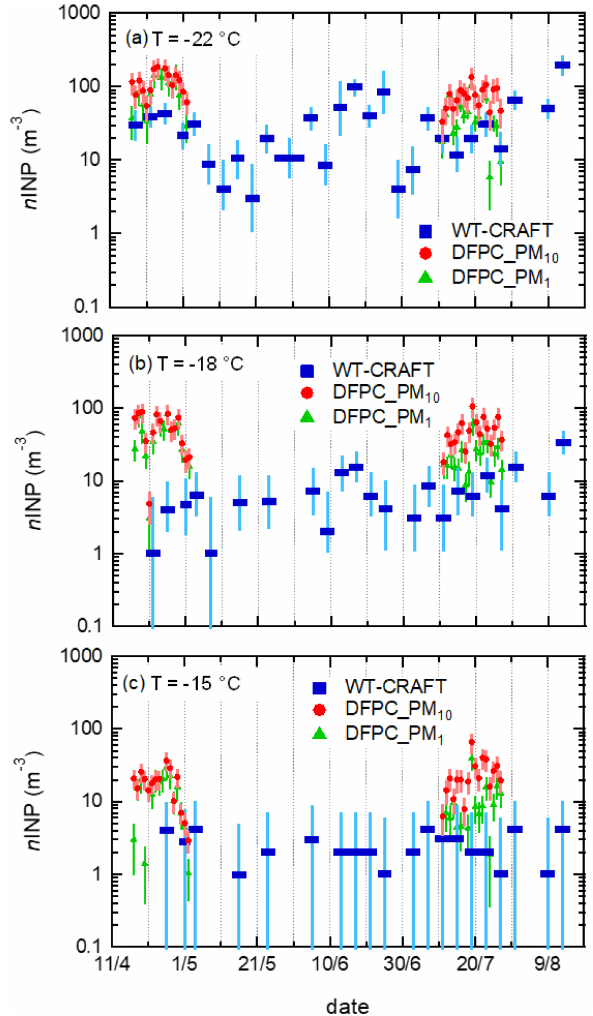
Figure 4. Time series of n INP at GVB during 2018 measured by DFPC (PM 10 and PM 1 ) and WT-CRAFT. Horizontal bars indi- cate the time span of WT-CRAFT samples (ca. 4d for the majority of samples). Vertical bars indicate the overall measurement uncer- tainty as indicated in Sect. 2.2.1 (DFPC) and 2.2.2